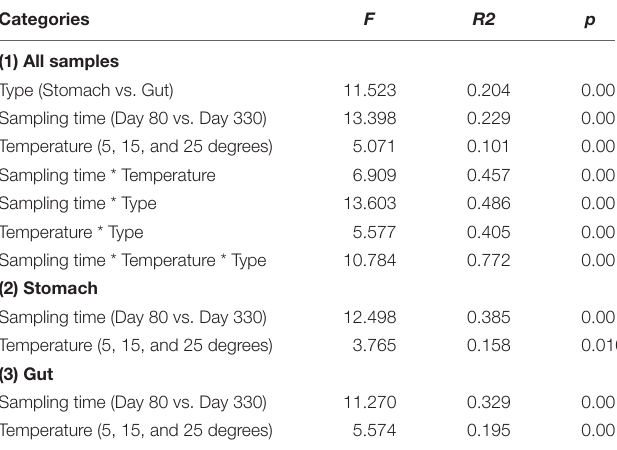
TABLE 2 | The Adonis analysis using unweighted Unifrac distance among the